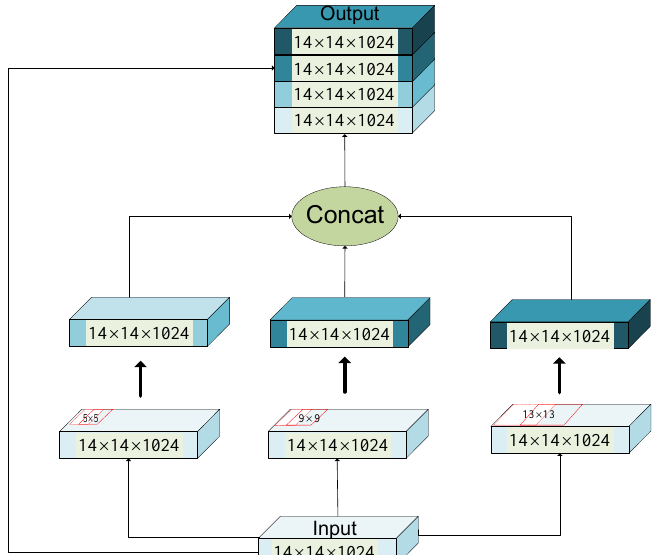
Figure 4. Improved spatial pyramid pooling module. Appl. Sci. 2021 , 11 , x FOR PEER REVIEW